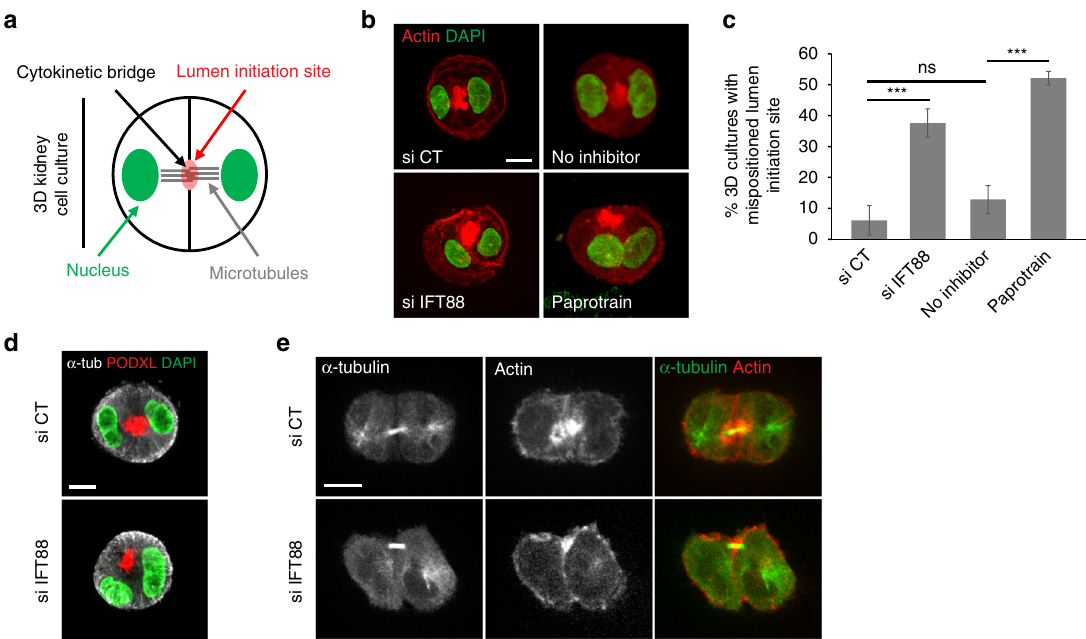
Fig. 5 IFT88 is required for lumen positioning in 3D renal cultures. a Schematics of kidney cells organization in 3D culture at the transition from one to two- cell stage. The cytokinetic bridge, where antiparallel MTs (grey) overlap, de fi nes the spatial landmark for the lumen initiation site (red). Under control condition, the lumen precursor (red) is centered between the two nuclei (green). b LLC-PK1 cells, depleted or not in IFT88 (left) and treated or not with Paprotrain (right), were grown in 3D on disk-shaped micropatterns for 24 h. Lumen positioning was monitored at two-cell stage, after the fi rst cell division, using actin (red). DAPI is shown in green. c Percentage of two-cell stage 3D cultures with mispositioned lumen initiation site as shown by both lateral actin accumulation and nuclei mispositioning. n > 30 two-cells stage. 3 experiments. Mean + / − s.d. ns: not signi fi cant compared to control; *** P < 0.001 compared to control siRNA and no inhibitor ( t test). d Lumen positioning was detected in LLC-PK1 cells depleted or not in IFT88 and grown in 3D using the lumen-promoting factor podocalyxin (PODXL: red). α -tubulin (grey) and DAPI (green) are shown. e Images showing that lumen mispositioning (actin, red) correlates with lateral cytokinetic bridge ( α -tubulin, green). Scale bars: 10 μ